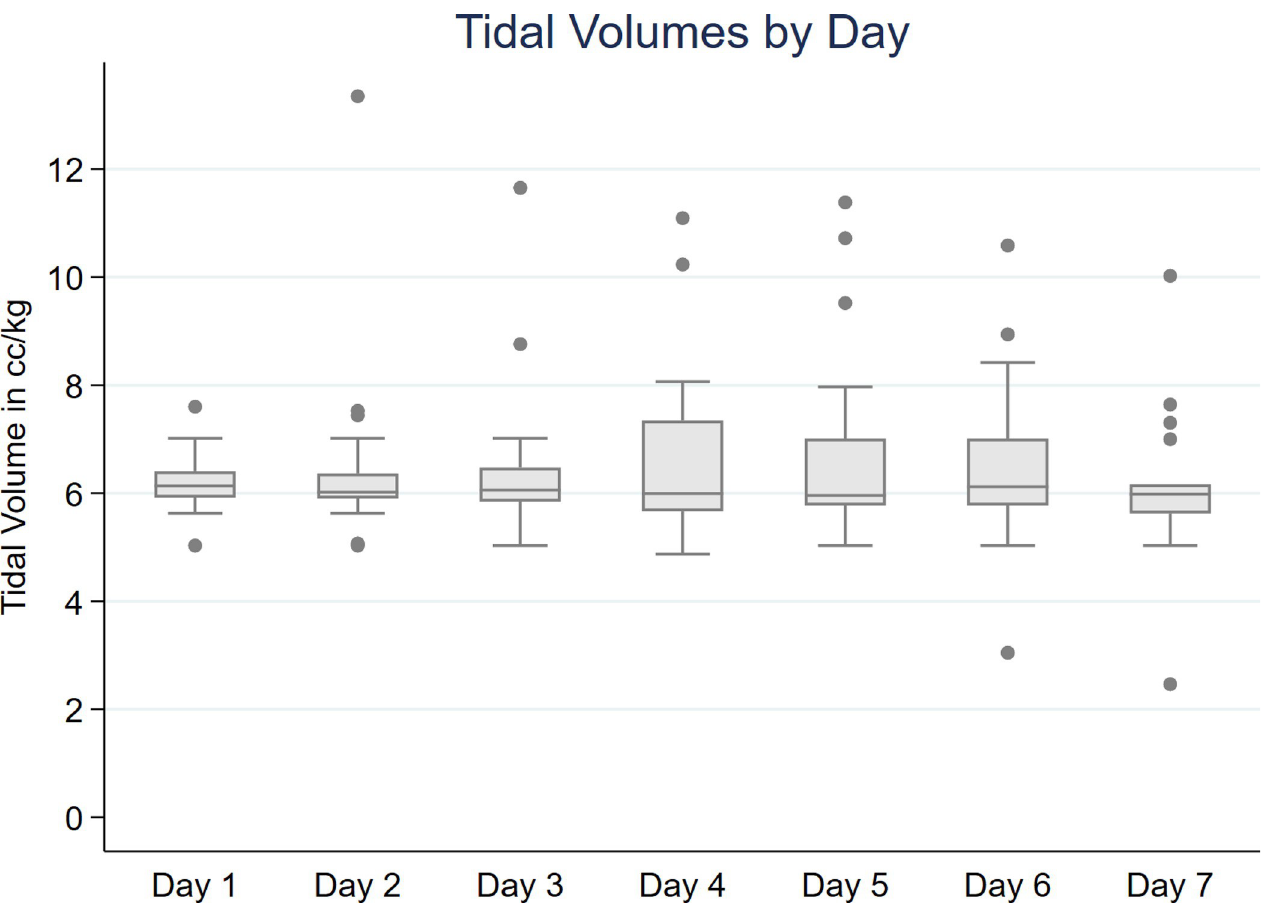
Fig 2. Box and whisker plot of pooled cohort mechanical ventilation tidal volume for first 7 days post-intubation. Tidal volume is displayed as cc/kg of predicted body weight. Box represents IQR and whiskers represent minimum and maximum, with outliers represented as dots.